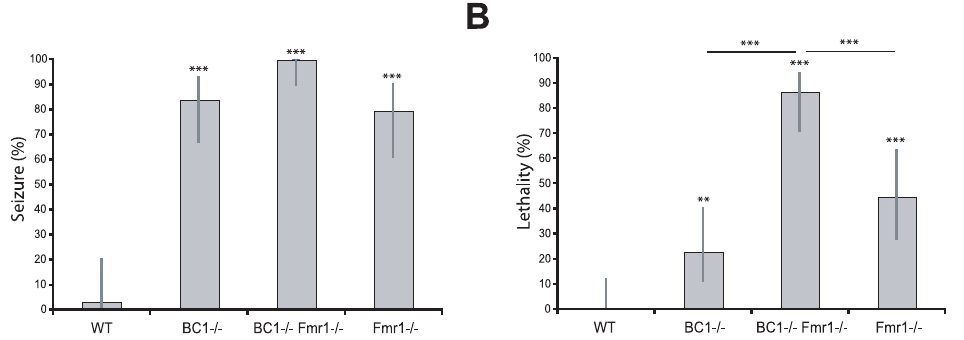
Figure 2. Severe epileptogenic susceptibility of BC1 2 / 2 Fmr1 2 / 2 dKO animals results in high lethality. ( A ) Lack of BC1 RNA, FMRP, or both, significantly increased propensity for audiogenic seizures (Generalized Linear Model, followed by post-hoc tests of pairs of groups using exact logistic regression stratified by litter; P , 0.0001 for each group when compared to WT). ( B ) Rate of lethality resulting from audiogenic seizures was significantly higher in BC1 2 / 2 Fmr1 2 / 2 animals than in BC1 2 / 2 animals (P , 0.0001) or in Fmr1 2 / 2 animals (P=0.0007). All mutant animals had a significantly higher audiogenic lethality rate compared with WT (BC1 2 / 2 Fmr1 2 / 2 , P , 0.0001; BC1 2 / 2 , P=0.008; Fmr1 2 / 2 , P , 0.0001). BC1 2 / 2 animals did not significantly differ from Fmr1 2 / 2 animals in audiogenic lethality (P=0.0719). Error bars represent 95% confidence intervals. WT,